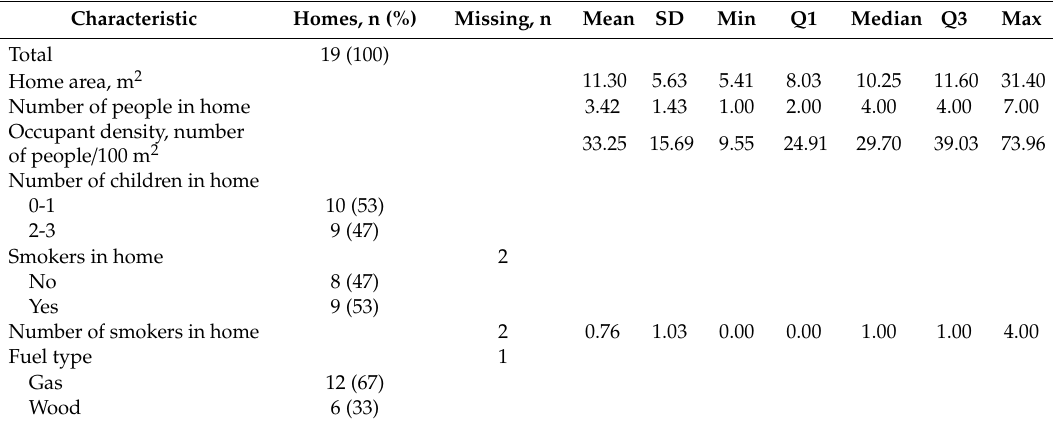
Table 1. Characteristics of homes at a brick kiln in Bhaktapur, Nepal, May 2019.